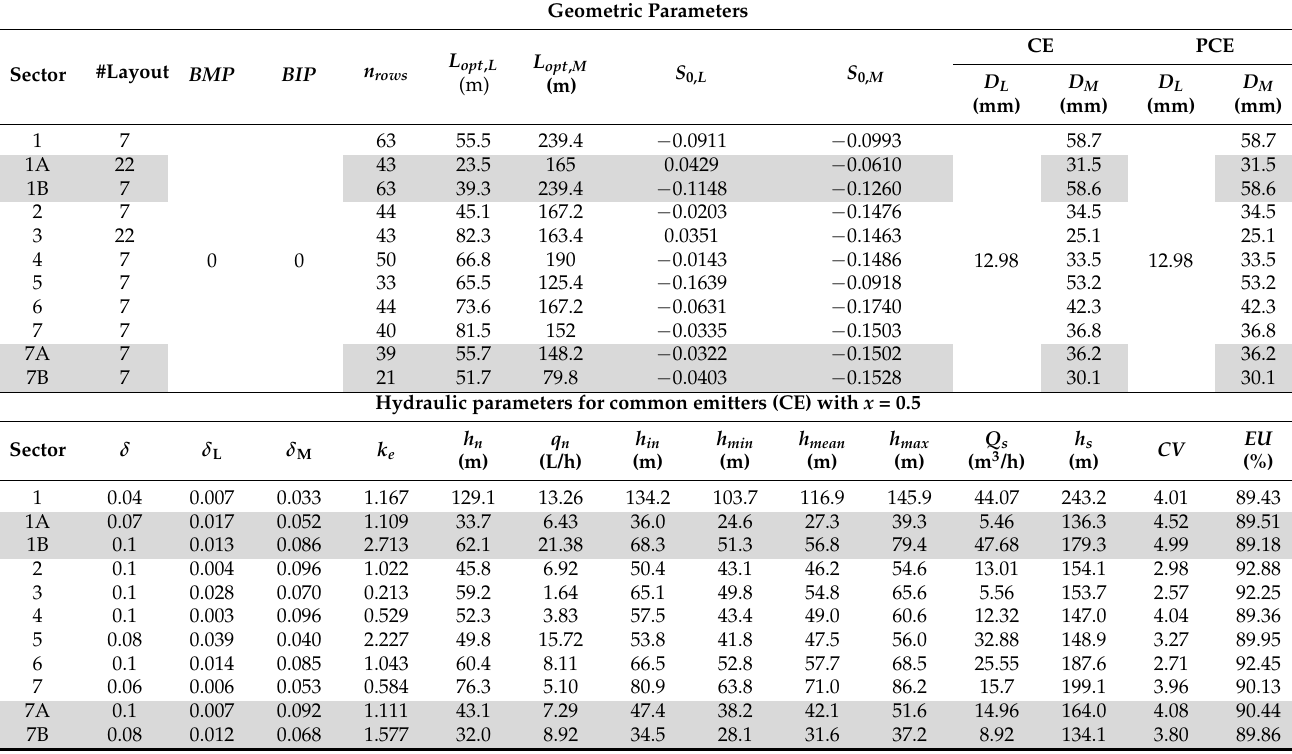
21 − 0.0403 − 0.1528 30.1 30.1 Hydraulic parameters for common emitters (CE) with x = 0.5 Sector